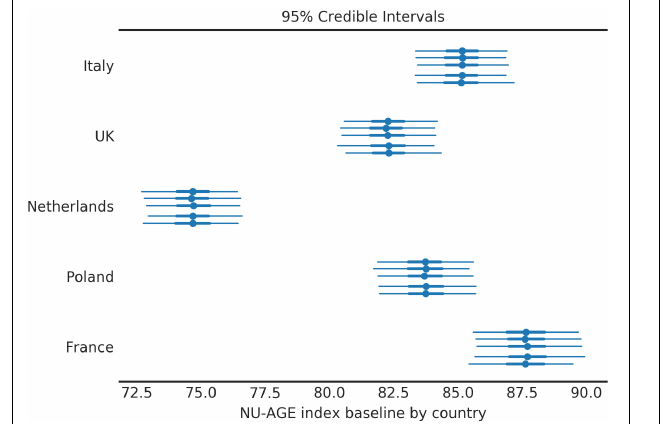
FIGURE 4 | NU-AGE index variation after 1 year intervention for the population divided by country. Four countries out of five behave similarly, while the French subjects had a noticeably higher NU-AGE index. Each country is divided into 5 segments to assess the variability among simulations (each simulation corresponds to one line). The central point represents the mean of the posterior distribution, the thick line the 50% HDI, the thin line the 95%